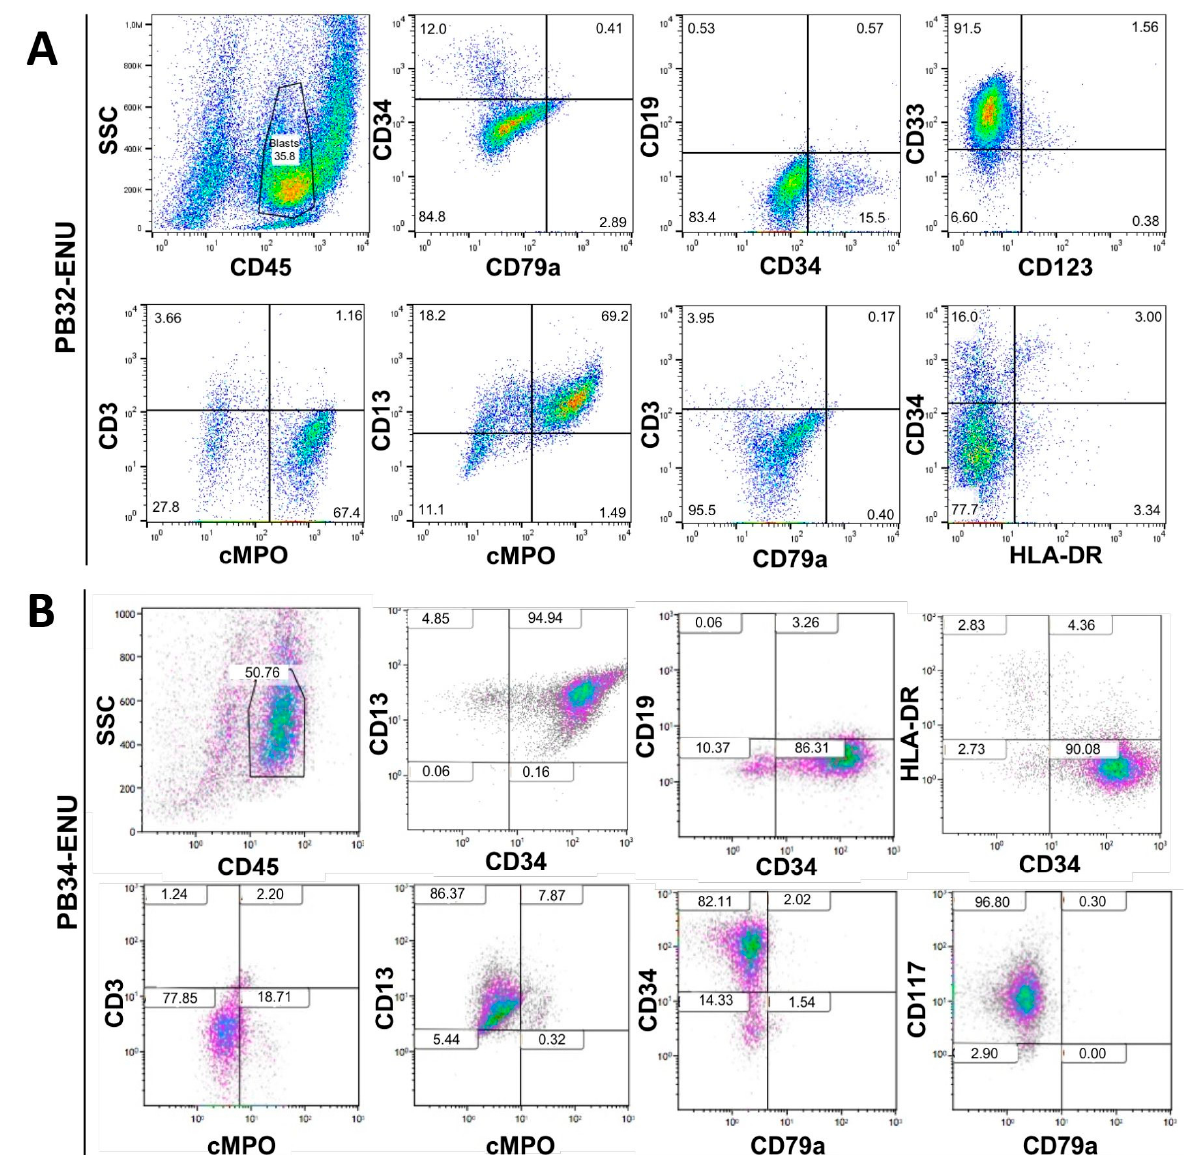
(Supplementary Figure S4). PB34-ENU-derived cells were highly positive for c-Kit (CD117). Both cell lines were negative for HLA-DR (Figure 3A,B).